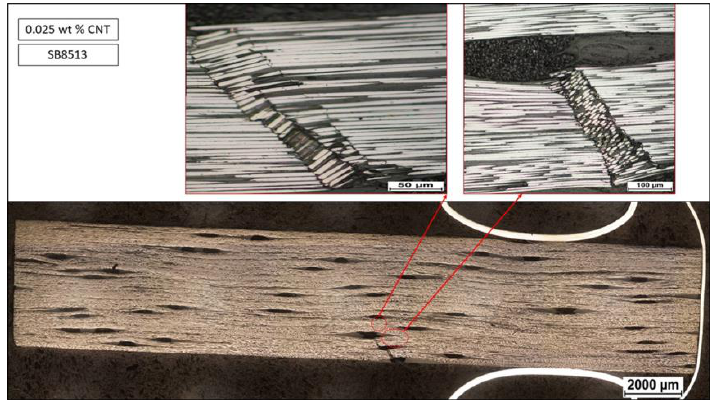
Figure 5. Micrograph of composite reinforced with 0.005 wt% CNT suspension-treated CF fabric short beam shear specimen after the test. The ( Bottom ) image shows an overview of the part of the specimen. ( Upper ) images indicate the fiber kinking that was formed during the failure.